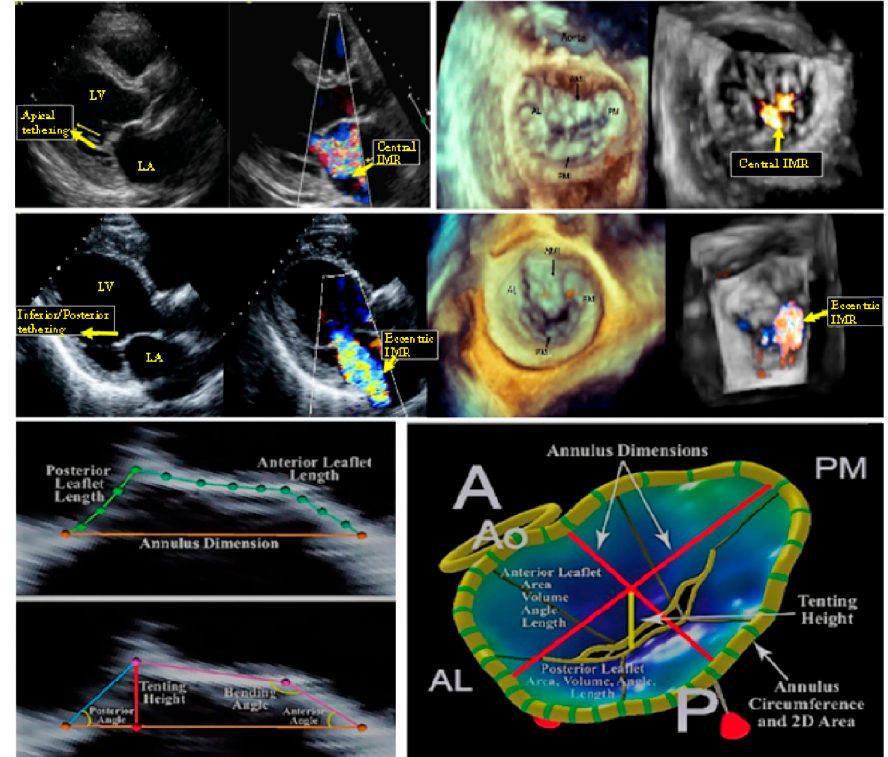
Figure 4. Top Panel. Symmetric pattern of mitral valve tethering determines biomechanical change in mitral valve configuration depicted on two- and three-dimensional echocardiography. ( Left ) Symmetric mitral valve leaflet tethering primarily in the apical direction results in a central ischemic mitral regurgitant jet. ( Right ) En face (surgeon’s view) of the mitral valve exemplifies a central, crescentic-shaped regurgitant orifice and MR jet. Middle Panel. Asymmetric pattern of mitral valve tethering determines biomechanical change in mitral valve configuration depicted on two- and three-dimensional echocardiography. ( Left ) Asymmetric mitral valve leaflet tethering in the inferior/posterior direction (yellow arrow) results in posteriorly-directed eccentric ischemic mitral regurgitation (IMR). ( Right ) En face (surgeons view) of the mitral valve exemplifies the resultant regurgitant orifice, which is more medially located, and the eccentric MR. Bottom panel. Two- and three-dimensional reconstruction of biomechanical change in mitral valve configuration. ( Left ) Representation of tenting area and tenting height. ( Right ) 3D TEE (transthoracic echography) reconstruction. AL = anterolateral commissure; AML = anterior mitral leaflet; IMR = ischemic mitral regurgitation; LA = left atrium; LV = left ventricle; PM = posteromedial commissure; PML = posterior mitral leaflet.